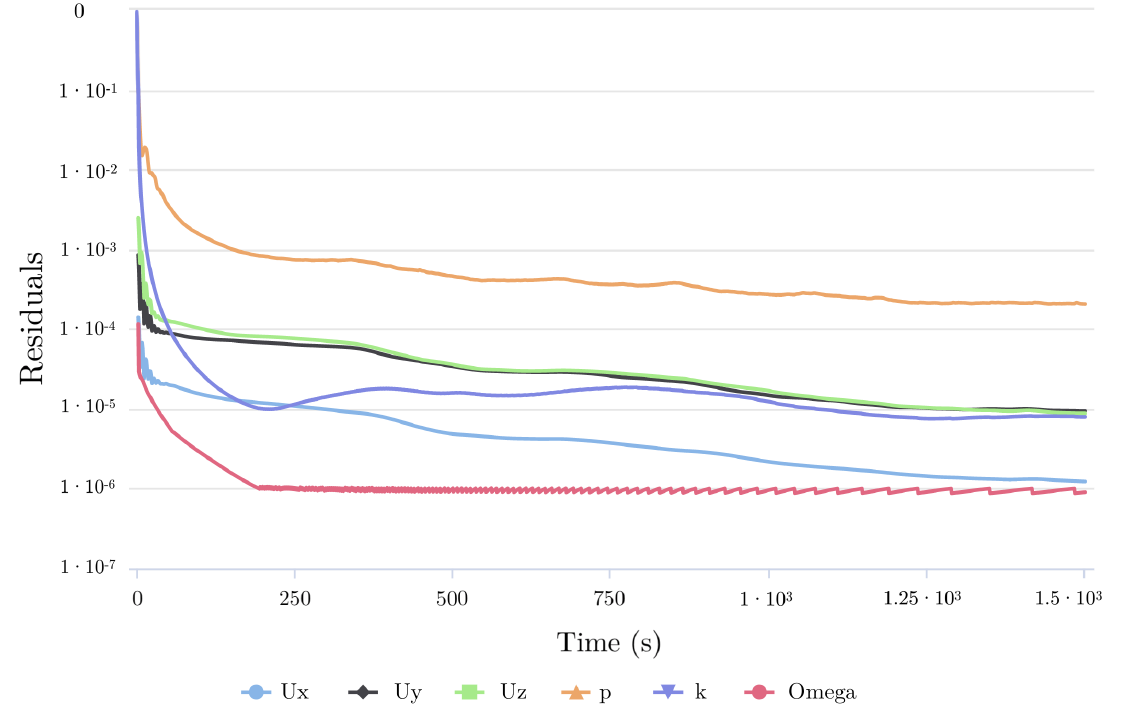
Figure 7. Residuals of the